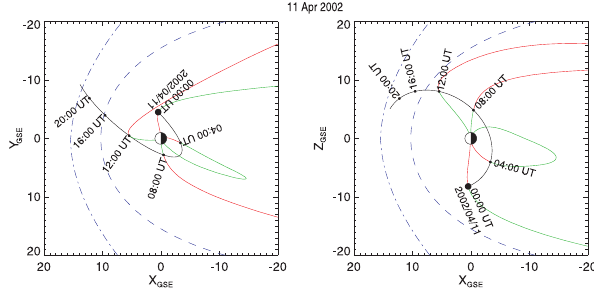
Fig. 3. Orbit of Cluster 3 in the XY and XZ GSE planes indicated by a solid black line, with tick marks every 4h. The dashed blue line in- dicates the position of the magnetopause and the bow shock is indi- cated by the dot-dashed blue line. When inside the magnetosphere, a magnetic field line has been traced from each tick mark location to the surface of the Earth or the magnetopause. Tracings parallel to the field (south-north) are shown in green and tracings anti-parallel (north-south) in red. (Courtesy of Cluster ground-based working